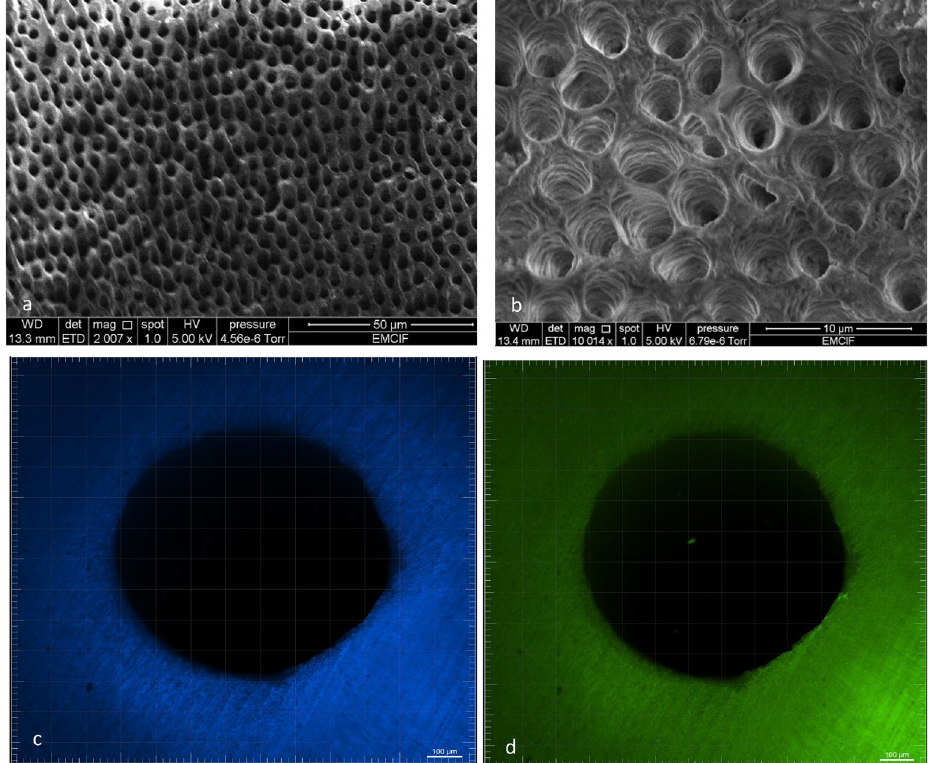
Figure 3. Illustrative image after GWS treatment—Scanning Electron Microscopy (SEM) image from the surface of the dentin ( a ) and the opening of the dentinal tubules ( b ) after GWS treatment; and Confocal Laser Scanning Microscopy (CLSM) (Middle third) ( c ) Blue (Excitation: 346; Emission: 442) and ( d ) Green (Excitation: 505 nm; Emission: 525